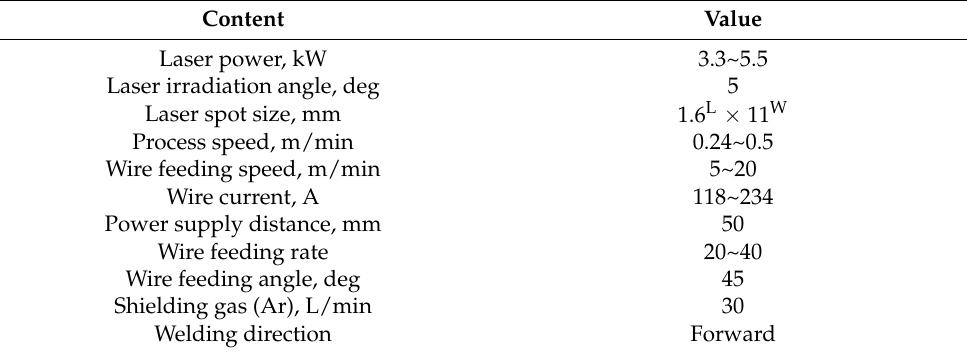
Table 2. Process parameters.